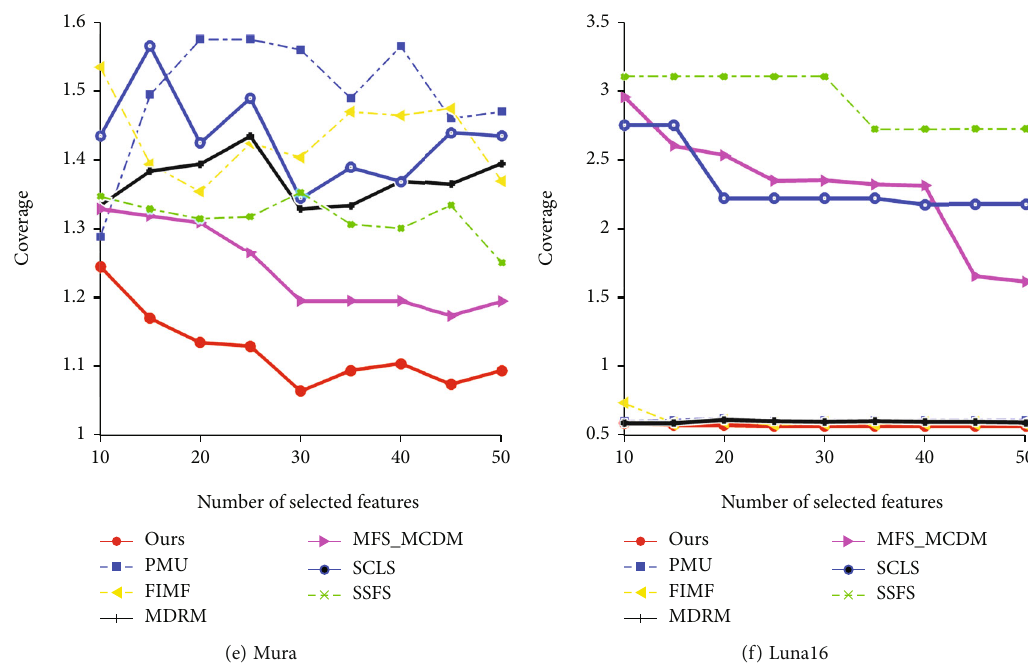
Figure 5: Coverage: the quality of each algorithm varies with the selected feature